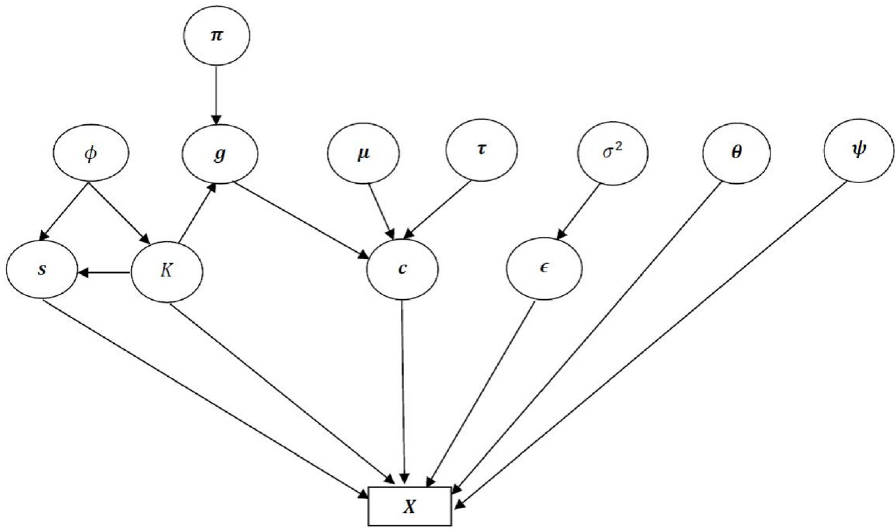
Fig 1. The conditional dependencies of the